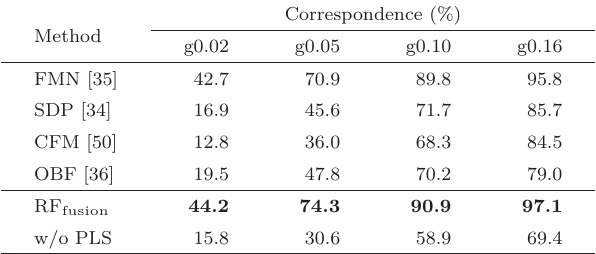
Table 3 Comparison of consistent correspondence by the proposed RF